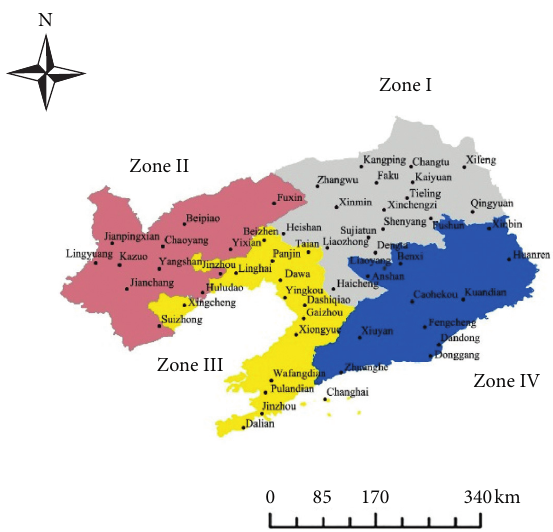
Figure 11: The specific regional